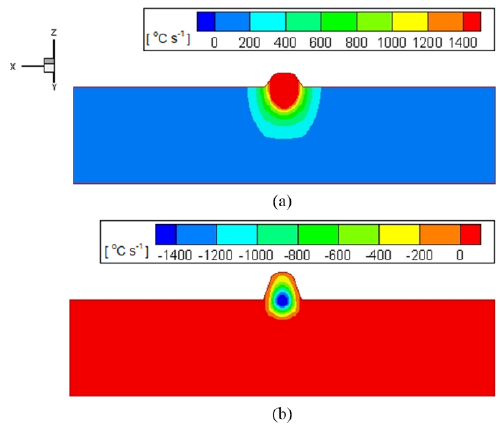
Figure 6. Optical micrograph from the evaluated regions after 2205 DSS welding.